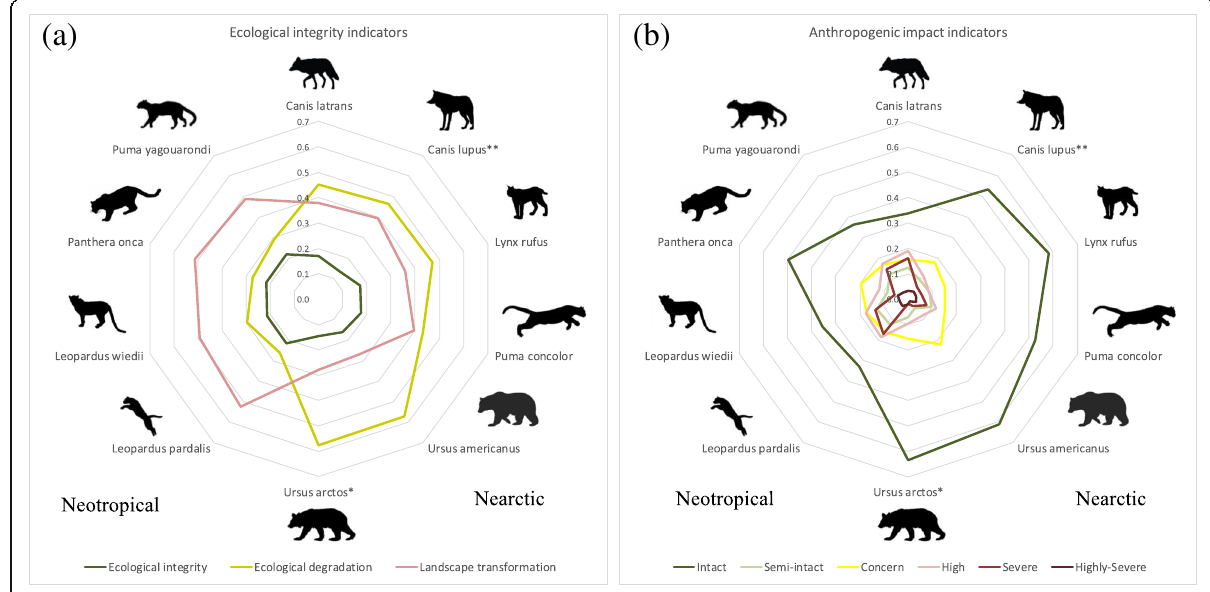
Fig. 6 Characterization of the historical distribution areas for all apex predators according to a the ecological integrity indicators, ecological degradation and landscape transformation, as well as b the impact baseline categories within distribution areas of